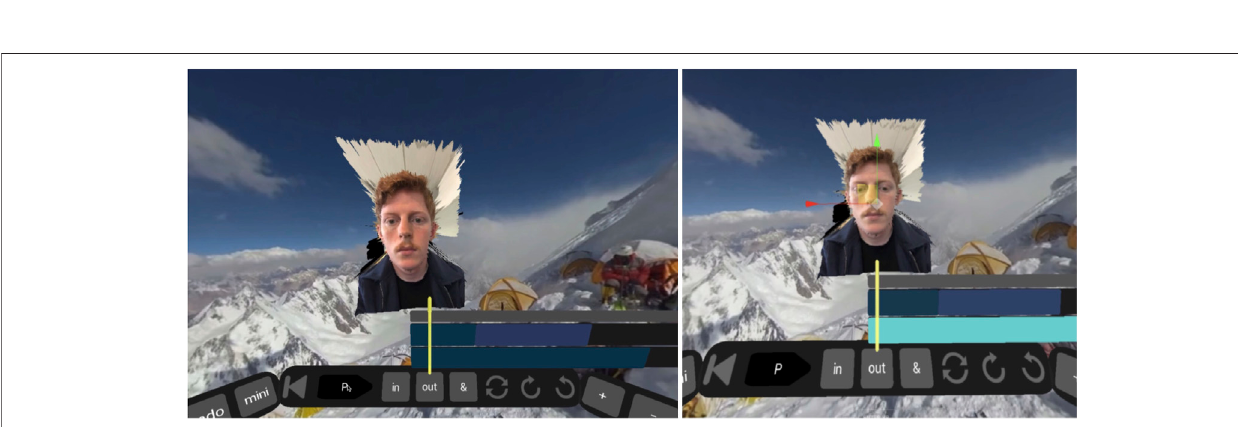
Frontiers in Virtual Reality |